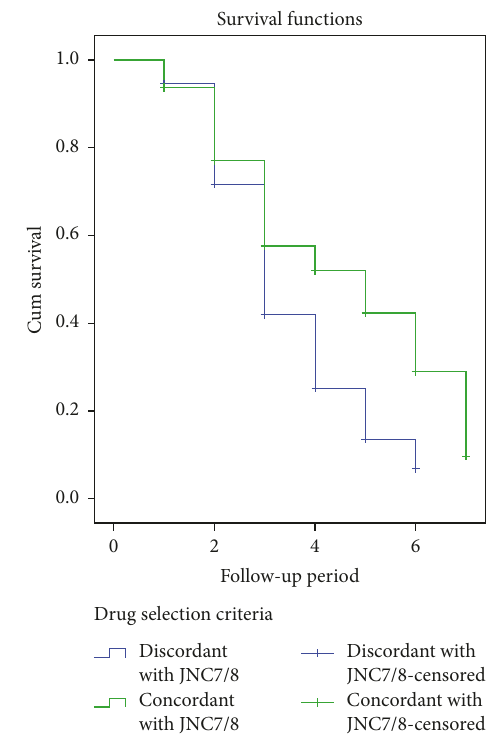
Figure 3: Kaplan Meier analysis curve of TOD based on